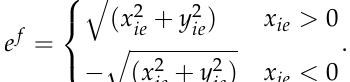
( b ) Figure 10. ( a ) Trajectory of rectangular formation by GCF; ( b ) Position error of rectangular for- mation over time. The motion trajectories of six robots are shown in Figure 9a, when a triangular for- mation is formed. The x-axis and y-axis are the coordinate changes during the motion of each robot. The curves of formation position error over time are shown in Figures 9b and 10b. The horizontal axis represents time. The vertical axis is the formation position error. The variation diagram of the position error of a multi-robot system with time is shown in Figure 9b. The diagram shows that the final multi-robot system would converge when t = 6 s. The position error variation diagram is shown in Figure 10b. Based on Figure 10b, it can be concluded that the final multi-robot system would converge when t = 4 s. In order to illustrate the effectiveness of the group consistency control designed in this article, the comparison of the two with and without group strategy are performed. The robot trajectory diagram and the system error diagram are obtained by formation control without using the group strategy, as shown in Figure 11. The trajectory diagram and system error diagram of the robot are gained by applying the group strategy, as shown in Figure 12.